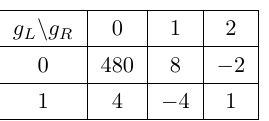
) = ( d 0 , 0) in E , d 2 , d 3 E ,